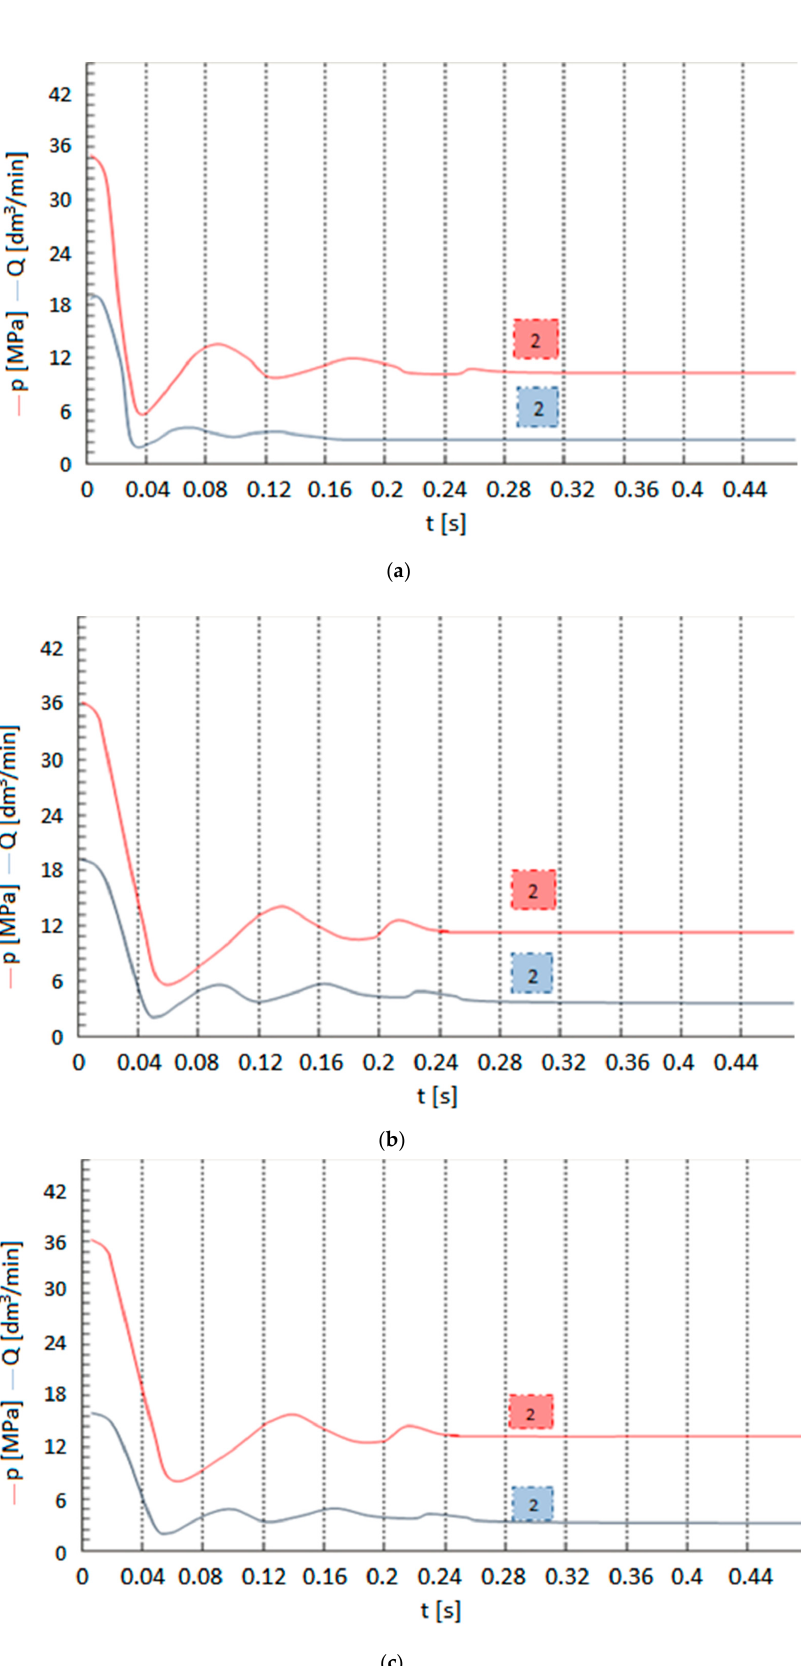
Figure 10. The Q and p time periods for code changes of the K p1 ·K p2 , Q rz , and F m parameters where Q